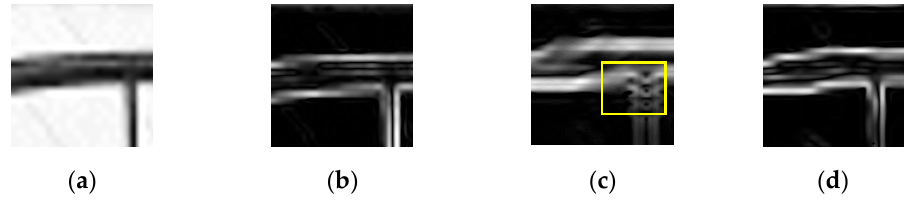
Figure 7. Comparison of visualization results for gradient estimation. ( a ) test image; ( b ) gradient calculation result of the test image; ( c ) gradient estimation result of the CGI method; ( d ) gradient estimation result of the GEI method.